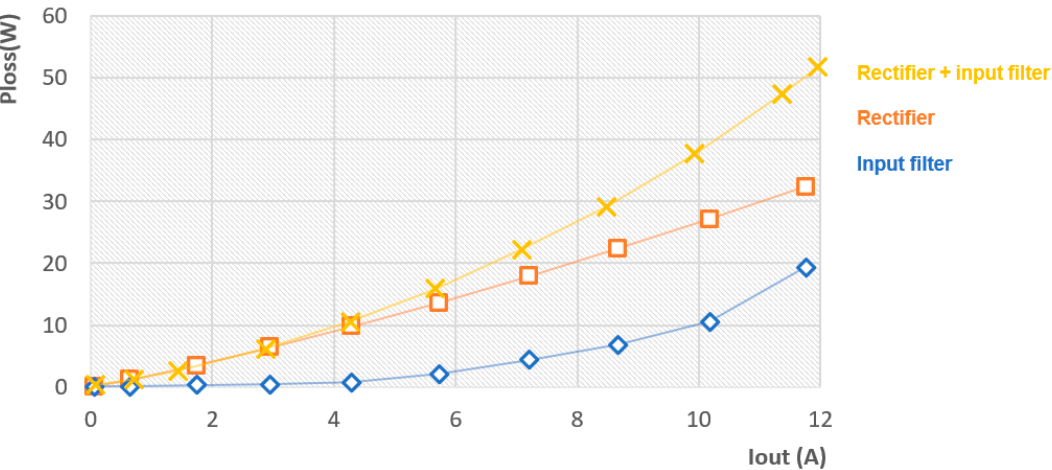
Figure 7. Efficiency characteristic of analyzed non-optimized PFC converter and power loss dependency on the output power of converter.